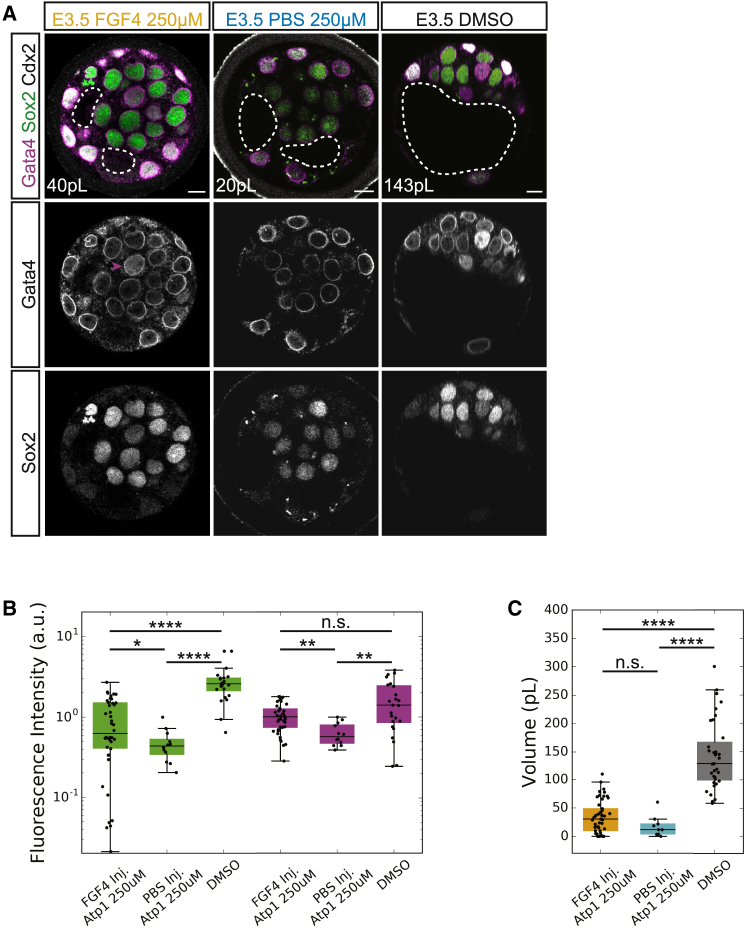
Luminal Deposition of FGF4 Partially Rescues EPI-PrE Specification in ATP1-Inhibited Embryos(A) Immunofluorescence images of EPI (Sox2) and PrE (Gata4) fate in E3.5 post-FGF4 deposition and Atp1 inhibition (E3.5 FGF4 250 μM), E3.5 post-PBS deposition and Atp1 inhibition (E3.5 PBS 250 μM), and E3.5 control embryos (E3.5 DMSO). White dotted line indicates lumen boundaries. Average lumen volume in white text. Magenta arrowhead indicates cell with high Gata4 expression relative to neighboring cells. Scale bars, 10 μm.(B) Boxplot of fluorescence levels of Sox2 (green) and Gata4 (magenta) in E3.5 post-FGF4 deposition and Atp1 inhibition (250 μM FGF4 Inj., N = 42 embryos), E3.5 post-PBS deposition and Atp1 inhibition (250 μM PBS Inj., N = 12), and E3.5 control embryos (DMSO, N = 12).(C) Boxplot of luminal volume in E3.5 post-FGF4 deposition and Atp1 inhibition (250 μM FGF4 Inj., N = 49 embryos), E3.5 post-PBS deposition and Atp1 inhibition (250μM PBS Inj., N = 9), and E3.5 control embryos (DMSO, N = 38).∗p < 0.05, ∗∗p < 0.01, ∗∗∗∗p < 0.0001. n.s., not significant.For boxplots: central mark indicates the median; lower edge, 25%; upper edge, 75%; lower whisker, Q1 − (1.5 × IQR), where IQR = Q3 − Q1; upper whisker, Q3 + (1.5 × IQR).